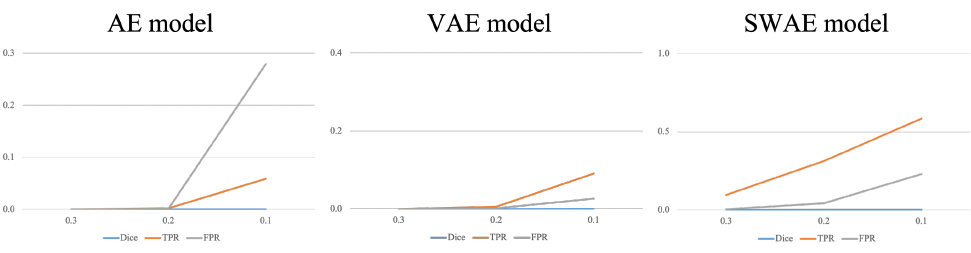
Figure 11. Changes in indicators according to the threshold for each model.